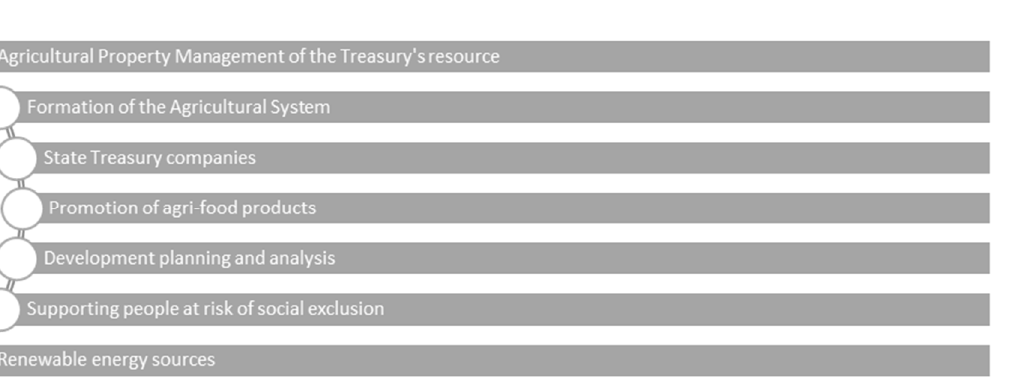
Figure 2. Thematic scope of activities of the National Agricultural Support Centre.